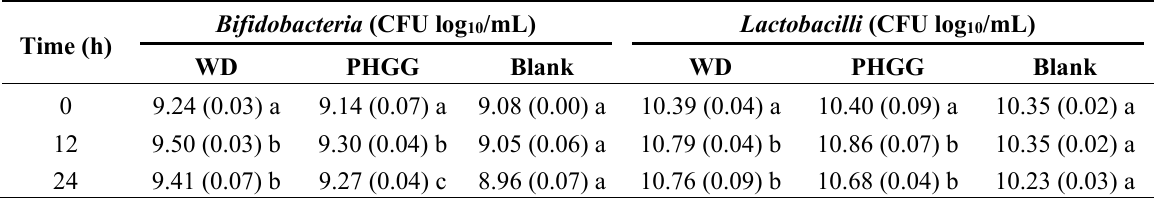
Table 3. Alterations in the Microbiota Concentration in Batch Culture Fermentation with WD and PHGG after 0, 12 and 24 h of Fermentation with Human Fecal